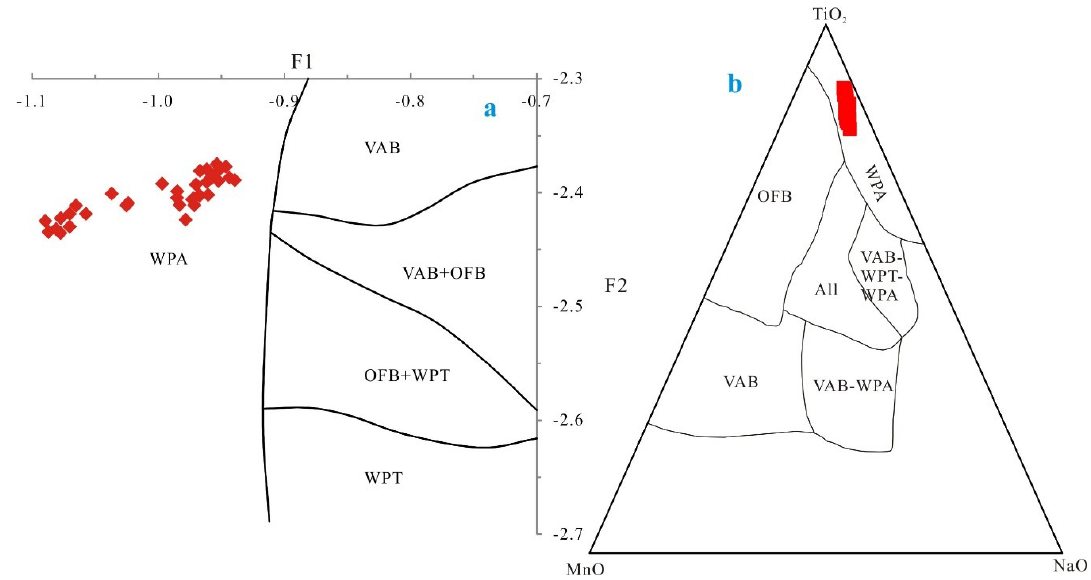
Figure 10. Tectonic discrimination diagram, proposed by Nisbet and Pearce [27]. ( a ) F1 vs. F2 tectonic discrimination diagrams; ( b ) TiO 2 -MnO-Na 2 O tectonic discrimination diagram. WPT: within-plate tholeiitic basalt; WPA: within-plate alkali basalt; VAB: volcanic arc basalt; and OFB: ocean floor basalt. F1 = 0.012 × SiO 2 − 0.0807 × TiO 2 + 0.0026 × Al 2 O 3 − 0.0012 × FeO* − 0.0026 × MnO + 0.0087 × MgO − 0.0128 × CaO − 0.0419 × Na 2 O;